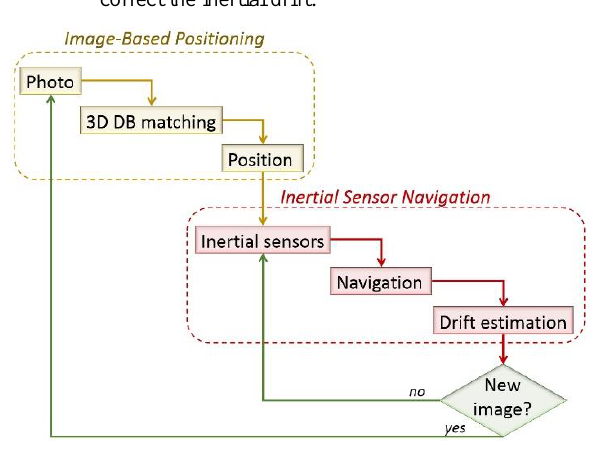
Figure 1 - The Image-Based Navigation